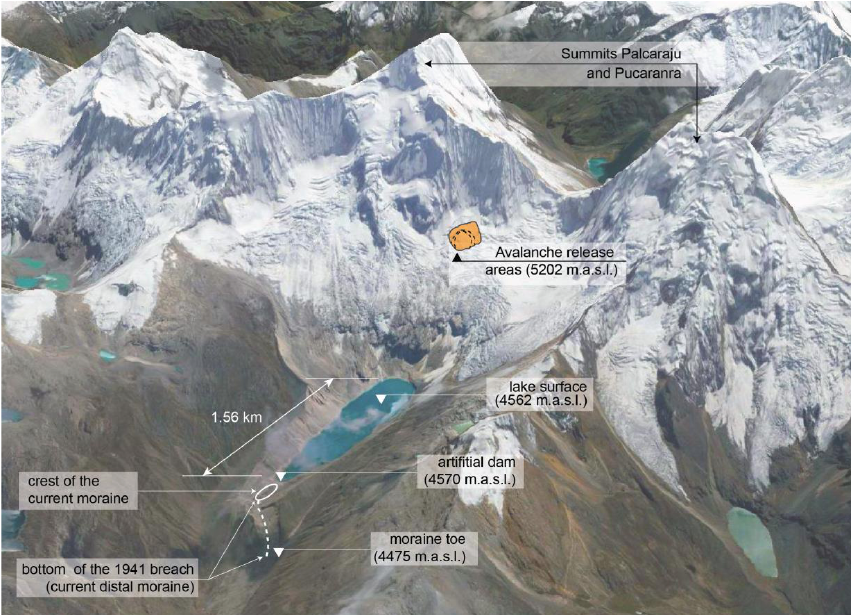
Figure 3. Lake Palcacocha in 2014 with Palcaraju (6274m) on the left and Pucaranra (6156m) on the right in the background and the 1941 GLOF breach below the lake. Potential avalanche release areas located at an elevation of 5202m to the northeast of Lake Palcacocha following the main axis of the lake (Google Earth, 2014).